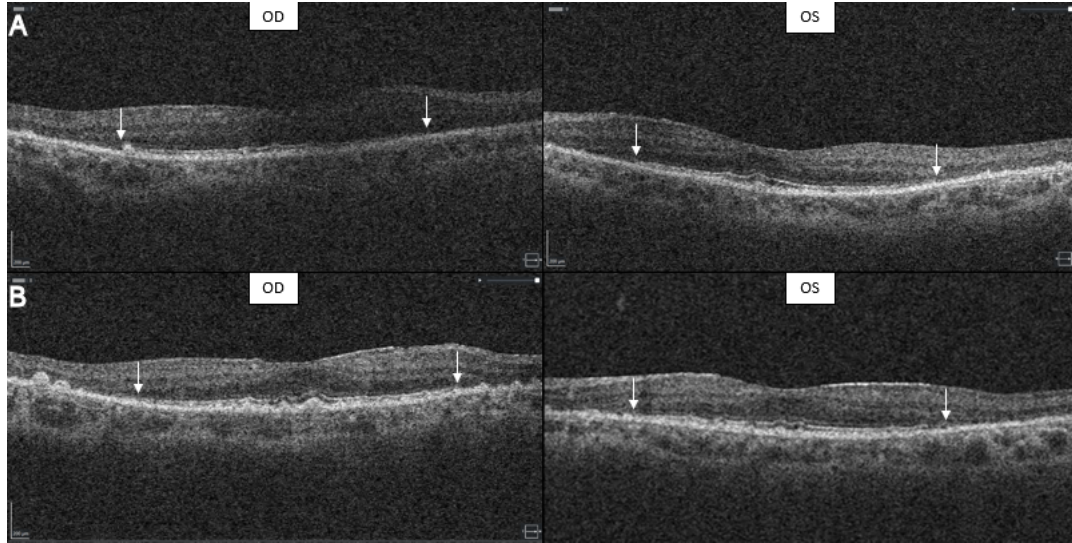
Figure 3: OCT examination in twin sisters with PPM2-CDG at the age of 41 For patient 1 (A) and patient 2 (B), severe attenuation of the outer retina starting from the perimacular area is shown. In the central macular area, the normal outer retinal structure was preserved. Drusenoïd like changes can also be observed, more obvious in the second